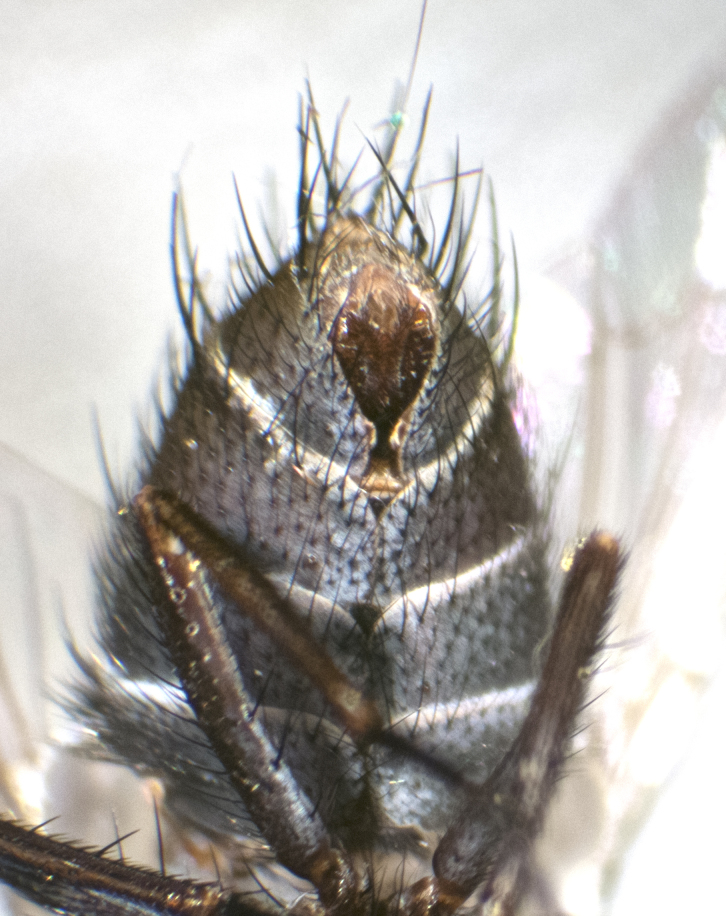
Ventral view of abdomen in Hyphantrophaga
guillermopereirai
sp. n. showing absence of sex patches